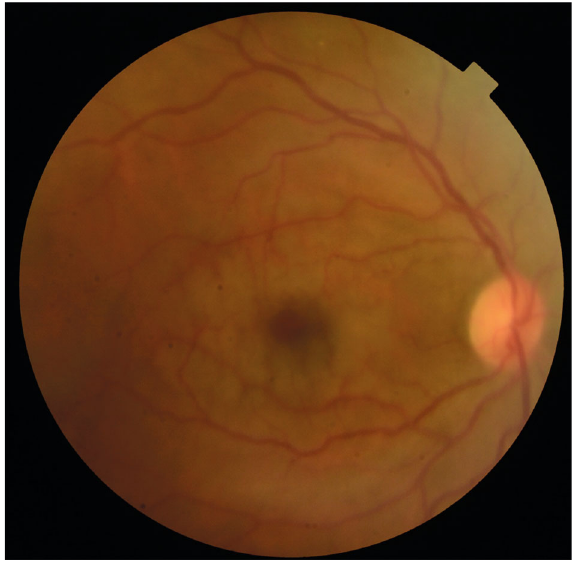
Figure 3: Postoperative fundus photograph of the right eye.